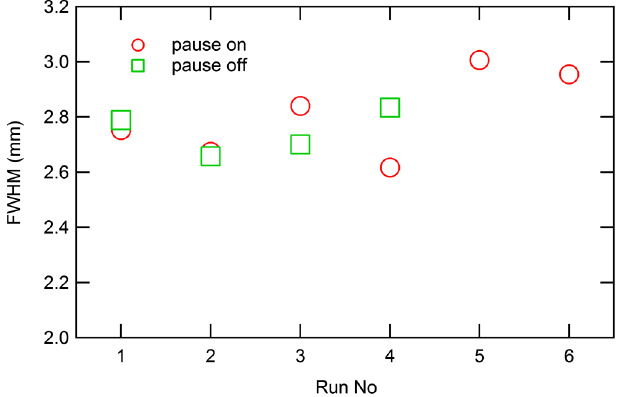
FIG. 10 (color online). Variations of the beam profile FWHM at beam current 5 mA measured with the prototype wire scanner. Circles denote set of runs with a 180 sec pause before the scan onset for the wire to stop vibrating; squares denote set of runs with a 20 sec pause (pause off) before the scan with the wire still vibrating. Error bars are smaller than the symbol size.